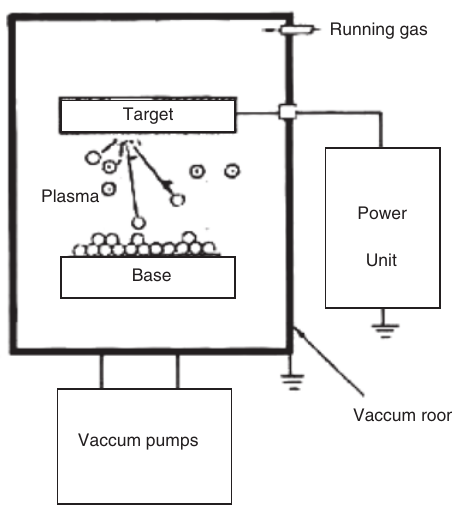
Figure 3 PVD reactive magnetron sputtering coating system.